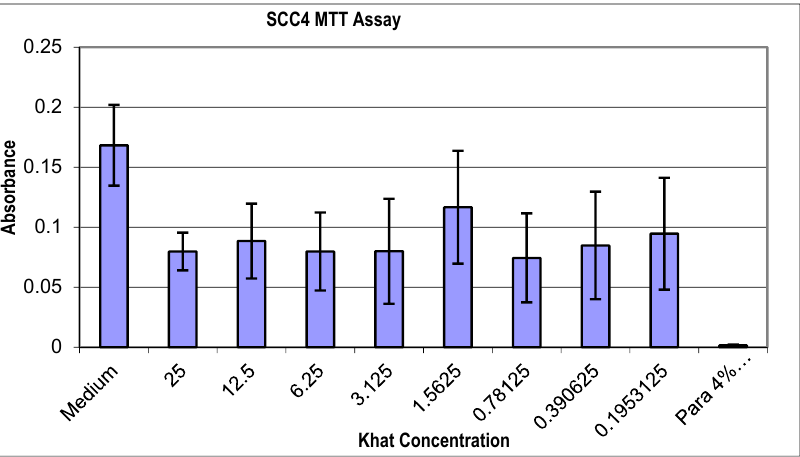
Figure 7. Absorbance from MTT Assay for SCC4 cells (late passage) treated with different concentrations of Khat solution (25 mg/mL to 0.195 mg/mL). Medium with only SCC4 cells was used as a negative control, while 4% paraformaldehyde was used as a positive control showing complete cell death.